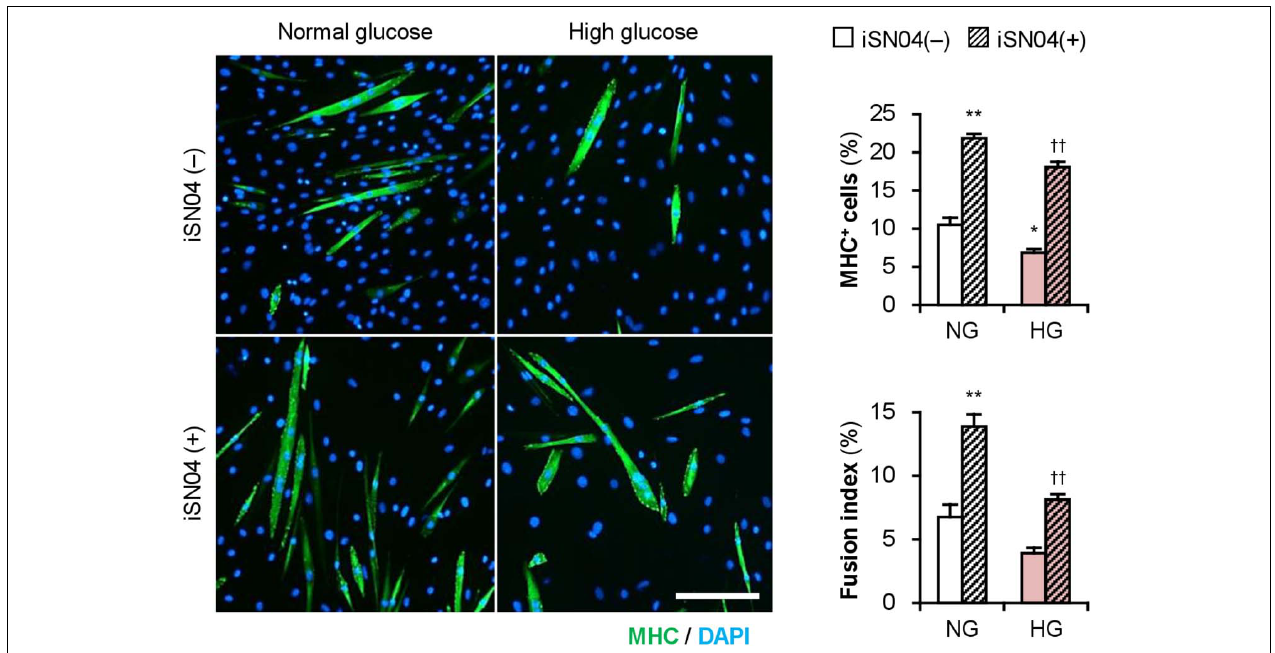
FIGURE 6 | iSN04 recovers the myoblast differentiation impaired by excessive glucose. Representative immunofluorescent images of the C2C12 cells differentiated in DIM with iSN04 for 4 days. Scale bar, 200 µ m. Ratio of MHC + cells and multinuclear myotubes were quantified. * p < 0.05, ** p < 0.01 vs. NG-iSN04(–); †† p < 0.01 vs. HG-iSN04(–) (Tukey–Kramer test); n =